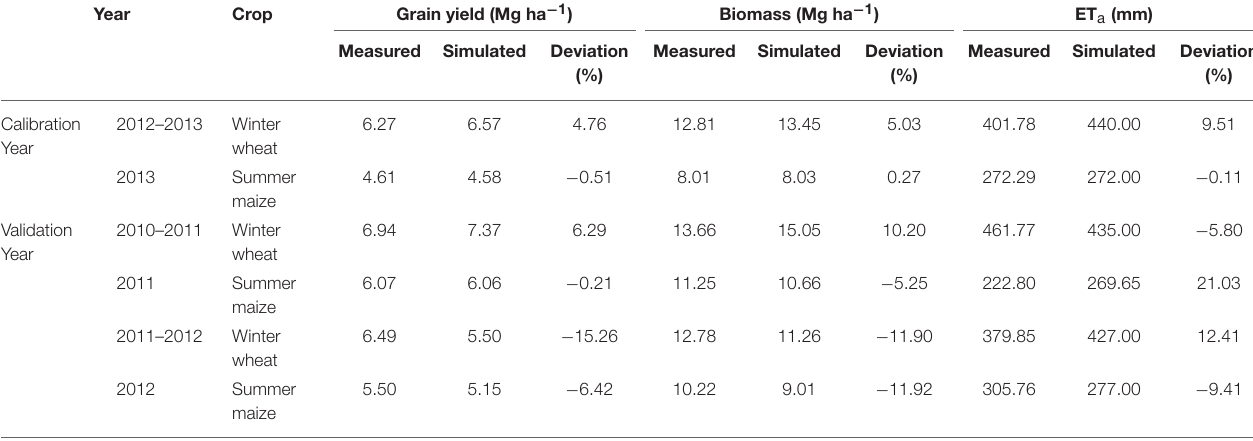
TABLE 5 | Measured vs. simulated results for calibrated and validated data sets of winter wheat and summer maize from 2010 to 2013 at Luancheng Agro-Ecosystem Experimental Station (LAEES). Year